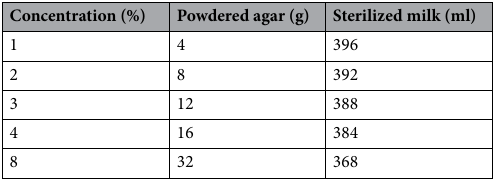
Table 2. Recipes for agar phantom gel preparation. Phantom gels with different concentrations of agar (1%, 2%, 3%, 4%, and 8%) were mixed with sterilized